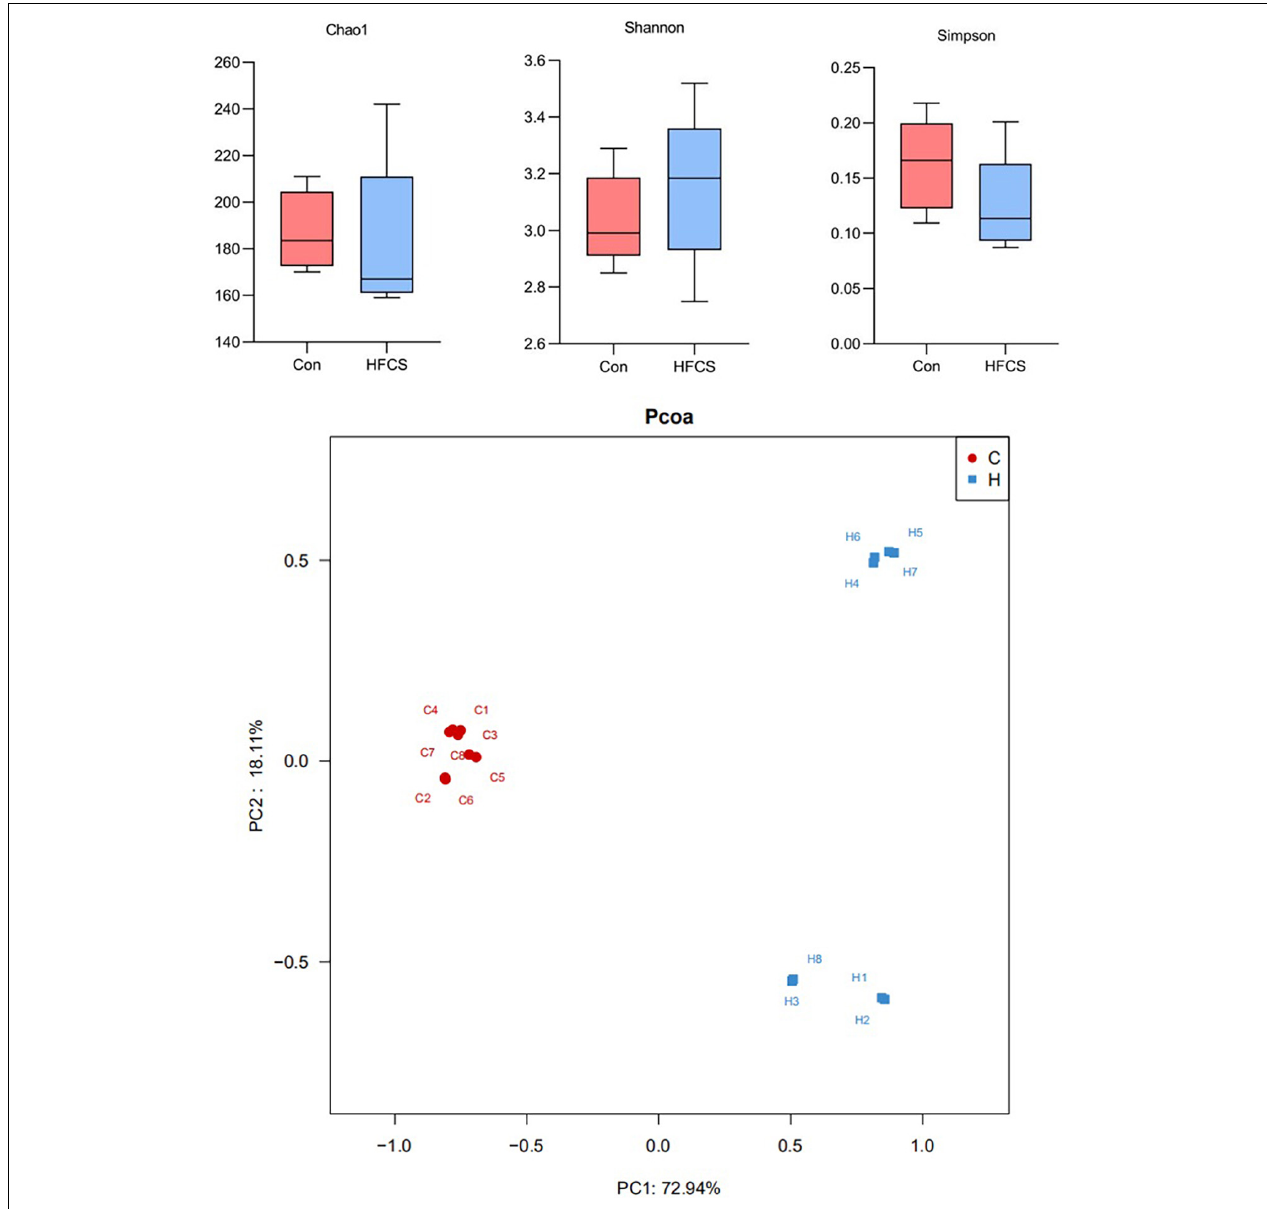
FIGURE 6 | Schematic diagram of alpha and beta diversity analyses. C, control; H, high-fructose corn syrup; PC, principal component ( n = 8).